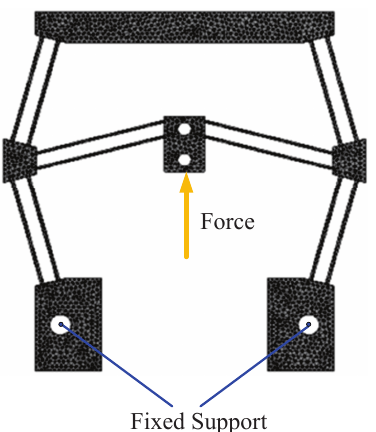
Figure 4. Finite element model of displacement reduction